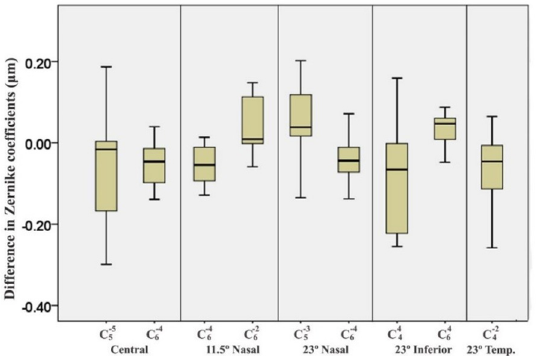
Figure 6. Differences between accommodated (with 2.5D of accommodation stimulation) and un- accommodated states of central Z(5, − 5) and Z(6, − 4), 11.5 ◦ nasal Z(6, − 4) and Z(6, − 2), 23 ◦ nasal Z(5, − 2) and Z(6, − 4), 23 ◦ inferior Z(4,4) (horizontal quatrefoil) and Z(6,4) and 23 ◦ temporal Z(4, − 2) (oblique secondary